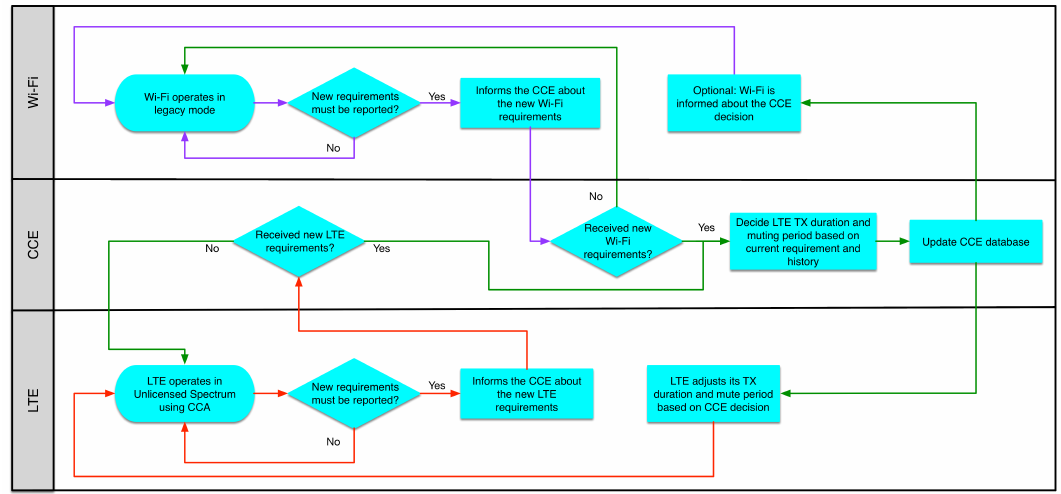
Figure 14. Flowchart of LTE and Wi-Fi transmissions adjustment by Central Coordination Entity